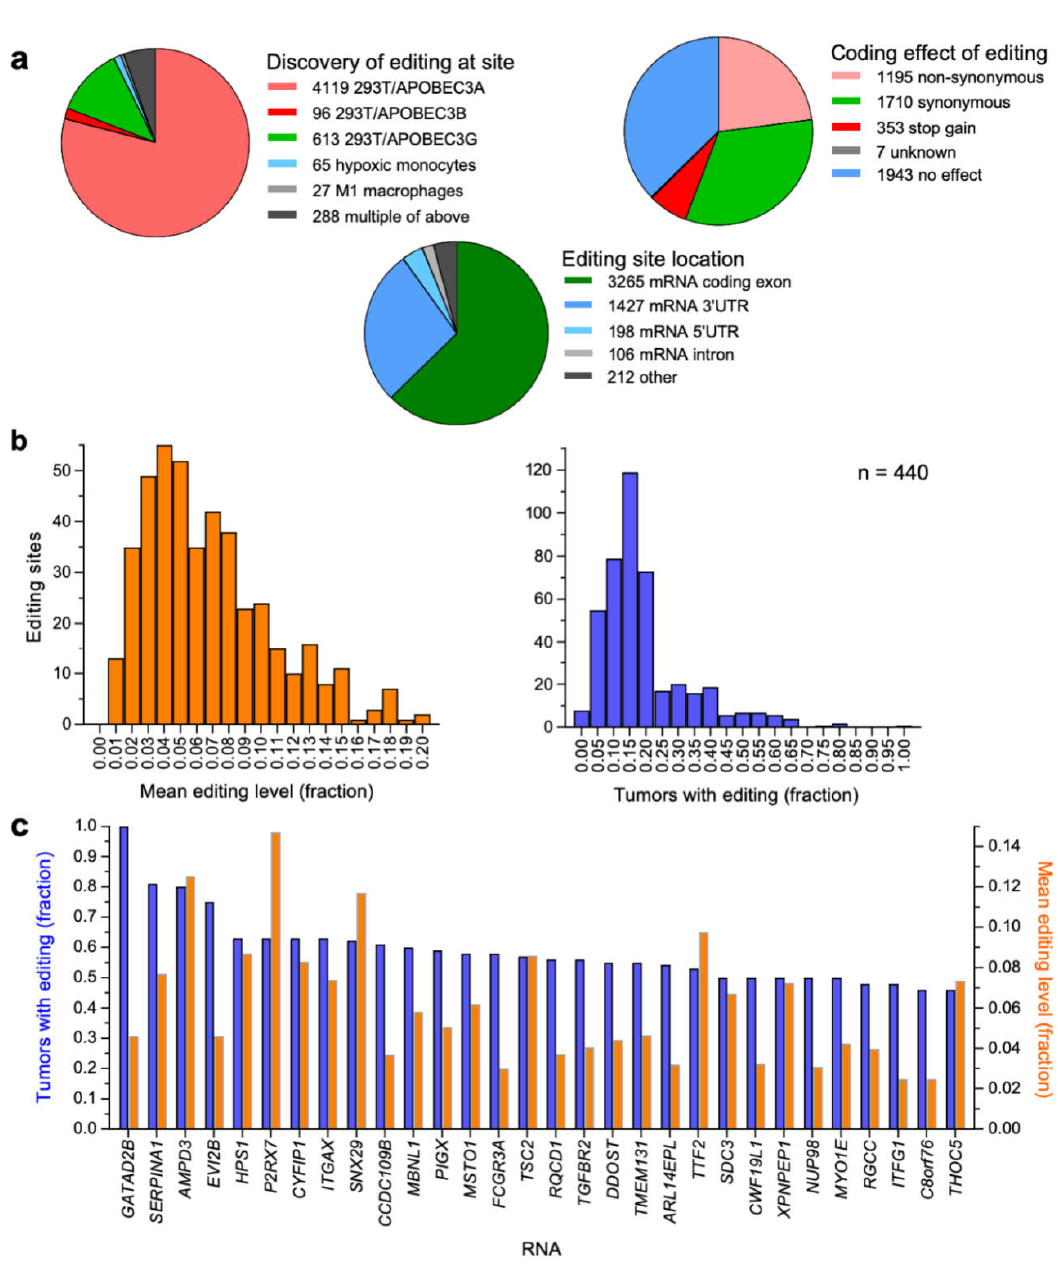
Figure 1. APOBEC3 - mediated RNA editing sites. ( a ) Characteristics of the sites that are examined in this study are illustrated with pie-charts. UTR, untranslated region. ( b ) Frequency histograms are shown for the fraction of The Cancer Genome Atlas (TCGA)-BRCA tumors with detectable RNA editing and the mean level of such editing for 440 sites for which editing was detected in the tumor cohort. ( c ) Fraction of tumors with editing and their mean editing level are shown for the 30 most commonly edited RNAs of the cohort.